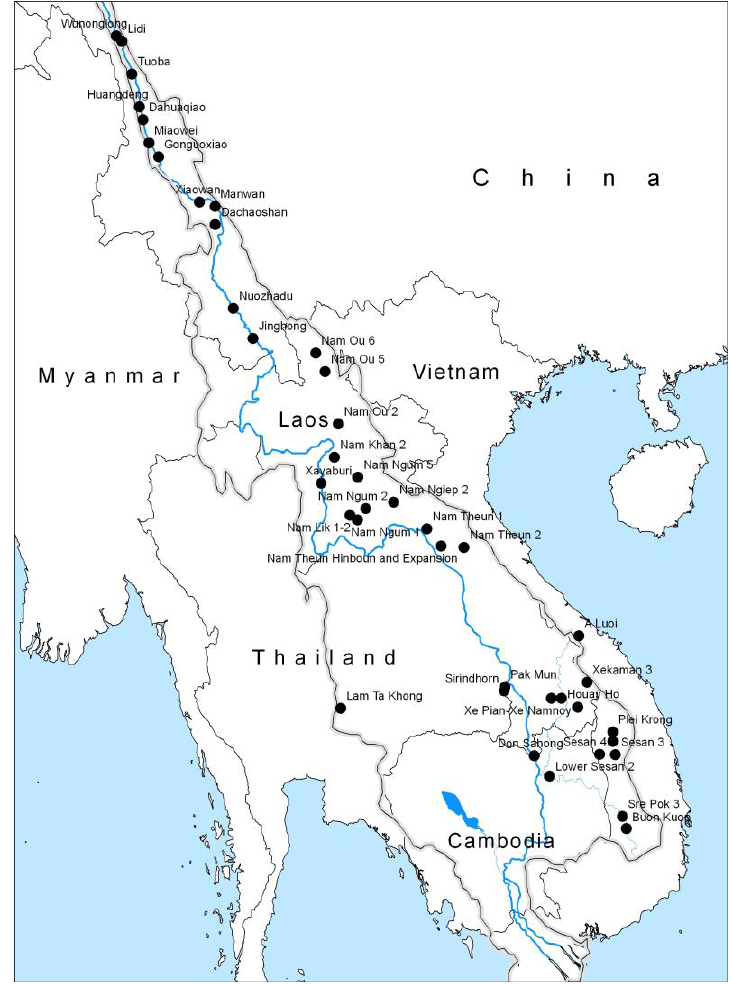
Figure 1. Map of the Mekong River Basin and hydropower dams with installed capacity of 100 MW or more. or